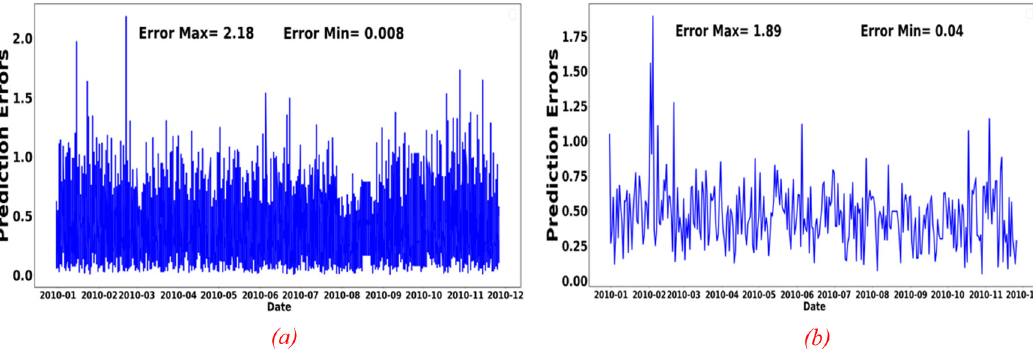
Figure 12: Household prediction errors of the optimal XGBoost model ( after tuning hyper parameters ) : ( a ) hourly granularity, and ( b ) daily